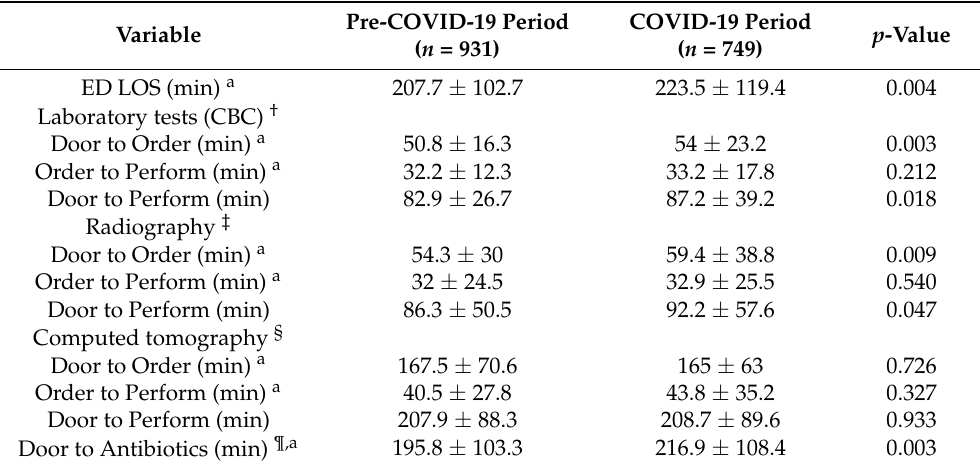
Table 3. The time variables of clinical processes by the Pre- and COVID period.